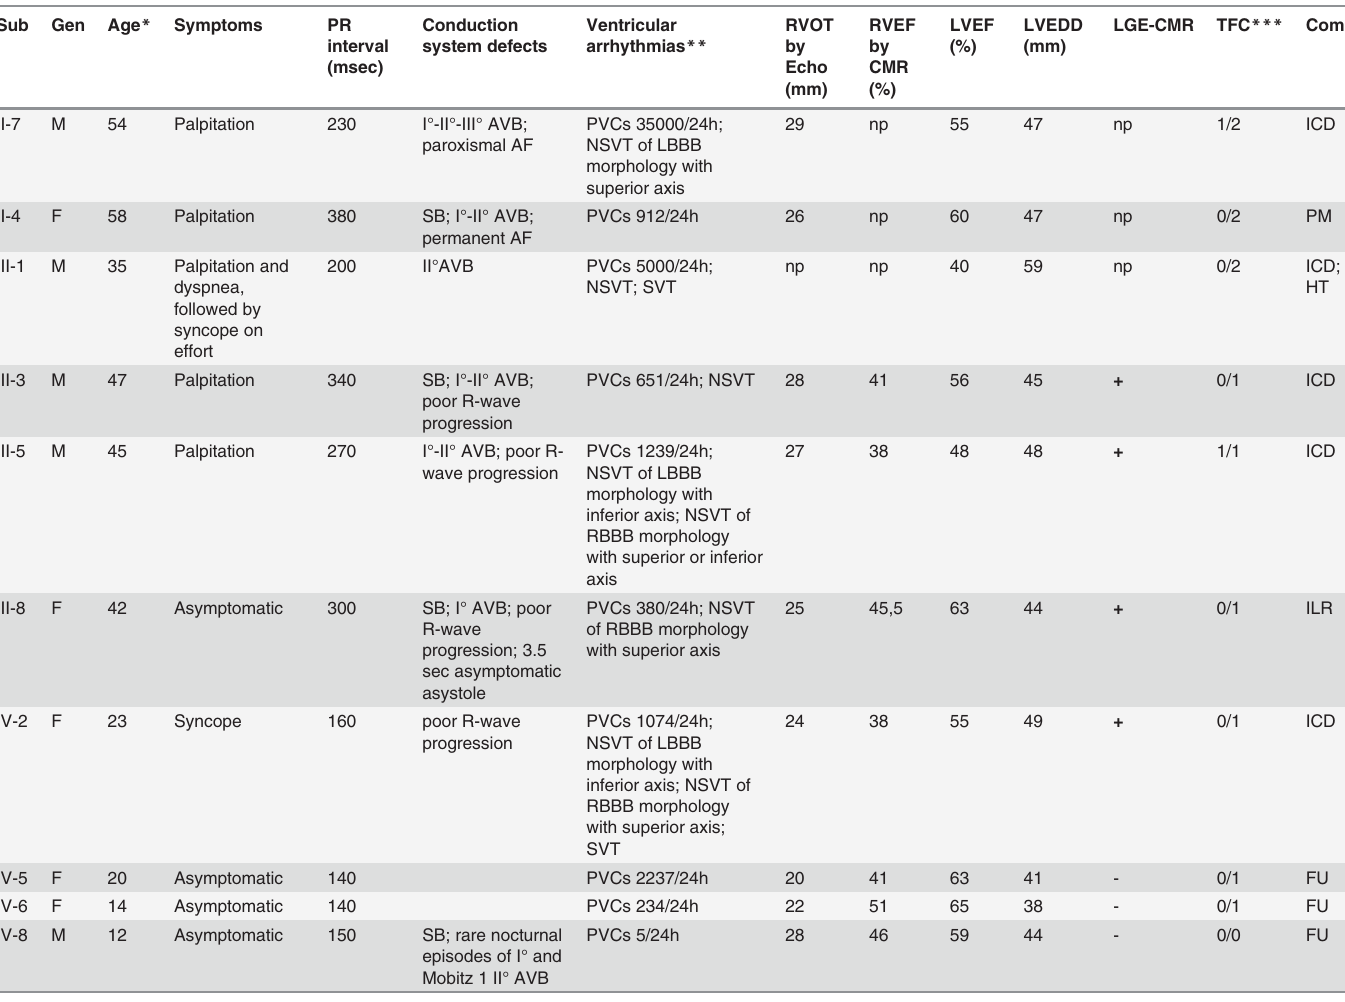
Table 2. Clinical characteristics of LMNA mutation-positive family